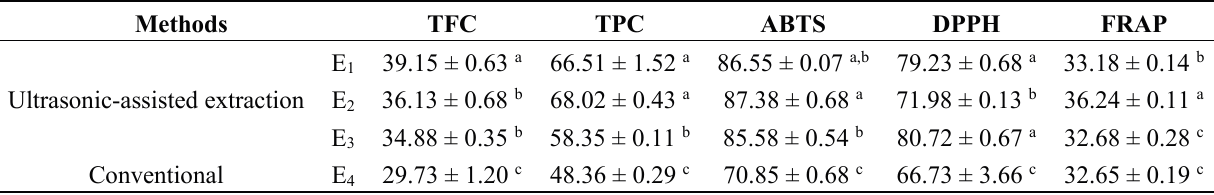
Table 6. The content of total flavonoids, phenolic, and antioxidant capacity of